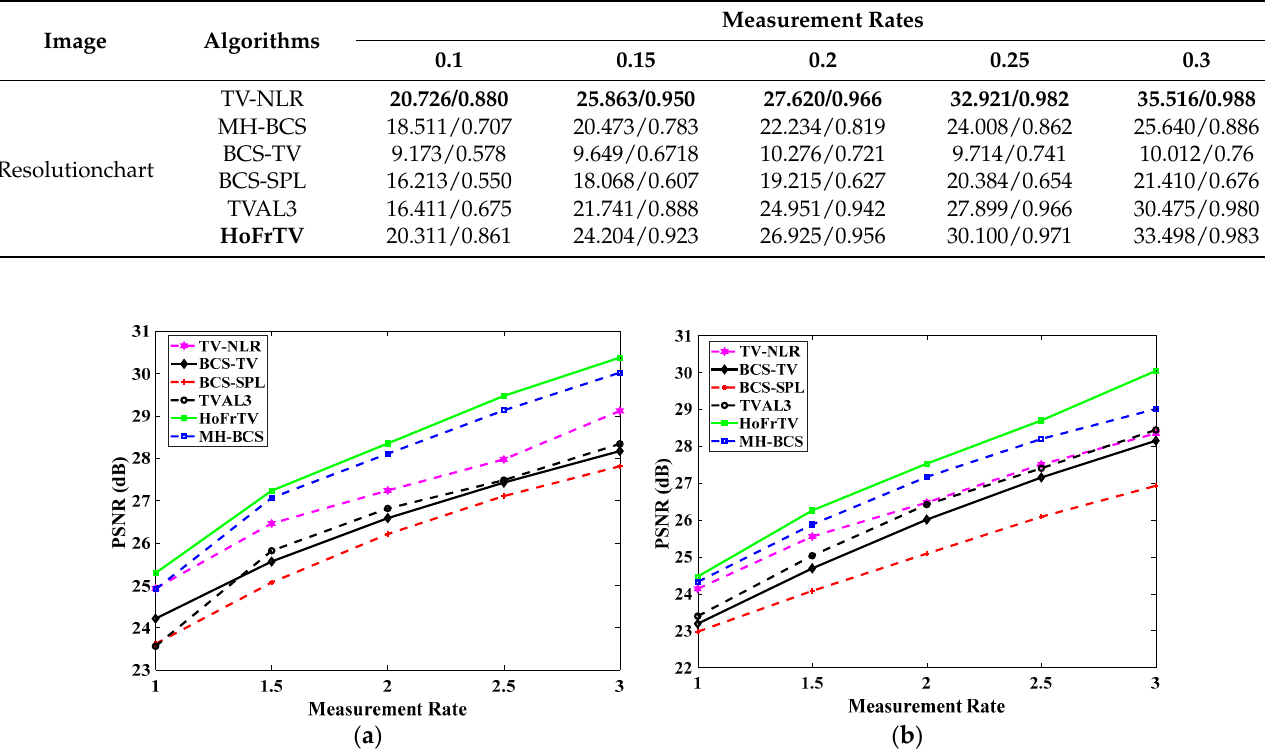
Figure 5. The PSNR curves of two images: ( a ) Barbara and ( b ) Boats.